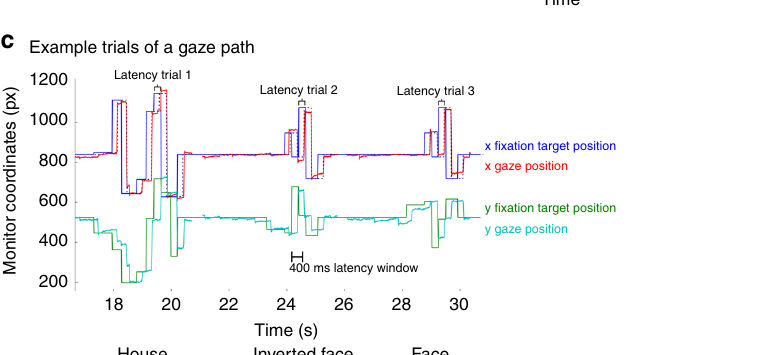
Fig. 1 Experimental design and fi xation patterns in Experiments 1 and 2. a An example picture for Face, inverted Face (shown as contour here for privacy protection) and a cartoon example of House stimuli (gray-scale pictures were used in the actual experiment; upper panel) and their corresponding fi xation patterns which were used for the Fixation Pattern task in Experiment 1 (middle panel) and Experiment 2 (lower panel). The fi xation patterns were collected from two subjects (indicated by blue and green, respectively) and pooled over all trials. For Experiment 2, the fi xation patterns for houses shown here were normalized to have the same level of spatial dispersion as the fi xation patterns for faces (see methods for details). b In the Fixation Pattern task the subjects were instructed always to fi xate the fi xation dot and to indicate at the end of the trial whether they had detected a target. c Visualization of the correspondence evaluation between fi xation dot position and gaze position of the subject by maximizing the cross-correlation. The position ( x , y coordinates, indicated by blue and green, respectively) of the fi xation dot and the actual eye position ( x , y coordinates, indicated by red and turquoise, respectively) of three consecutive trials collected from one subject are shown as a function of time. The x- axis indicates the time (in seconds) relative to the onset of the fi rst trial. The correspondence was measured by calculating the cross-correlation between the time series of the fi xation-dot position and the time series of the actual eye position. Note, the data here is only shown as an example to visualize the two time Pictures of faces and houses typically lead to increased activation than face patterns, with inverted face patterns in activation in the FFA, respectively, PPA 3,4 . Would this also be between. Similarly, the early visual areas (V1 – V4) showed the case for face and house-speci fi c gaze tracks? A repeated stronger activation for house fi xation patterns (Fig. 3a, right; measures ANOVA on BOLD-signal changes with the factors ROI see Supplementary Notes for a full ANOVA). The strong (PPA, FFA, FEF, SPL) and fi xation pattern (Face, inverted Face activation by house fi xation sequences — mirrored by the and House) revealed a signi fi cant main effect of fi xation pattern analogous tendencies in the FEF and SPL — may have been due (F(2,40) = 3.72, p = 0.033). House patterns led to stronger to low-level differences in saccade amplitude that were higher in